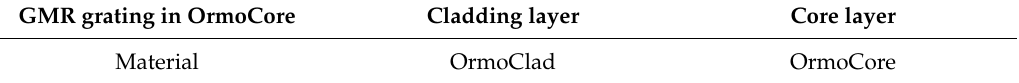
Table 3. The parameters used for realizing the OrmoCore and EpoCore GMR grating sensor foils.